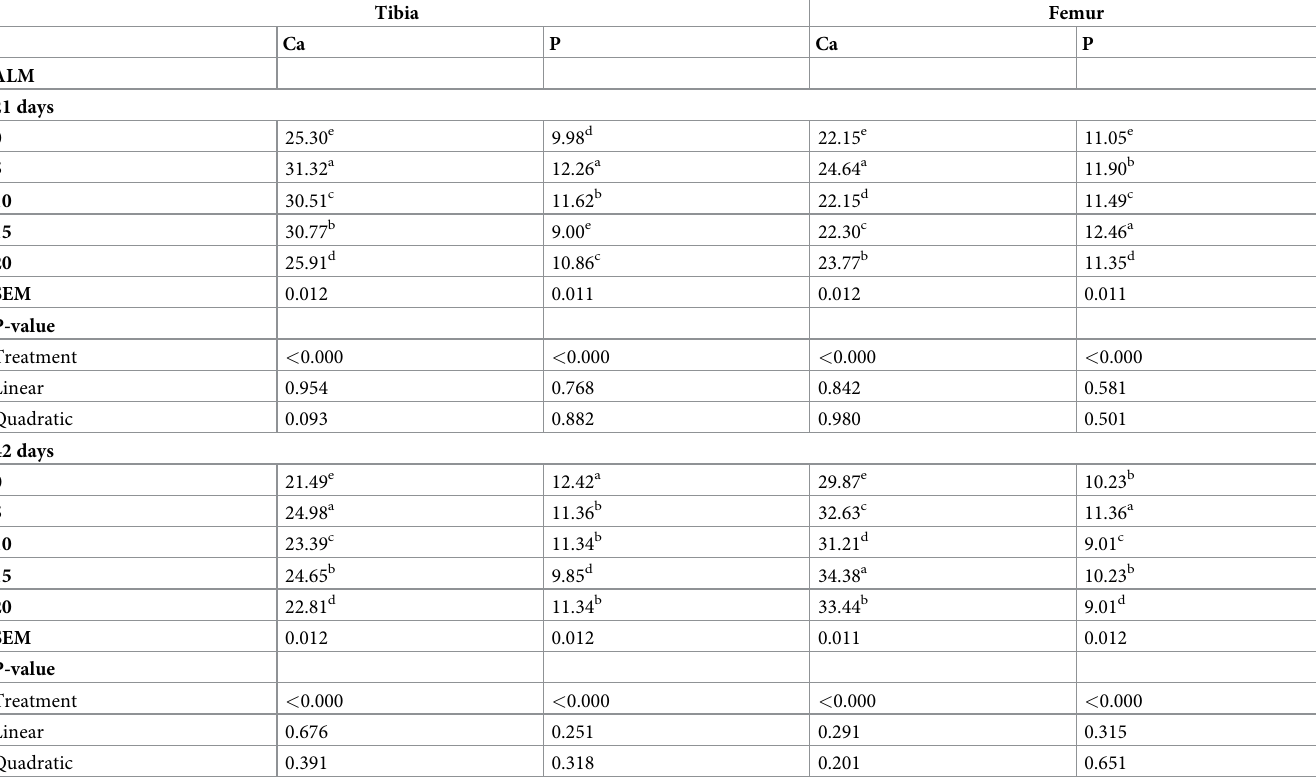
Table 10. Effect of amaranth inclusion leaf meal on bone minerals of Ross 308 broiler chickens. Tibia Femur Ca P